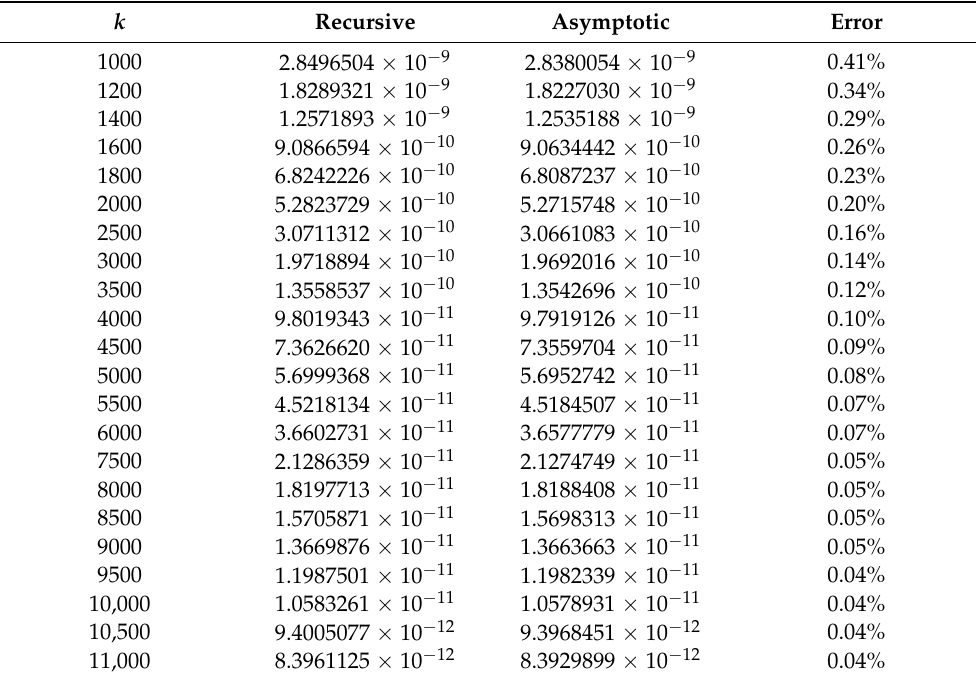
Table 3. Comparison of exact and asymptotic p k . m = 58.7, (cid:101) = 0.005, w = 0.7.